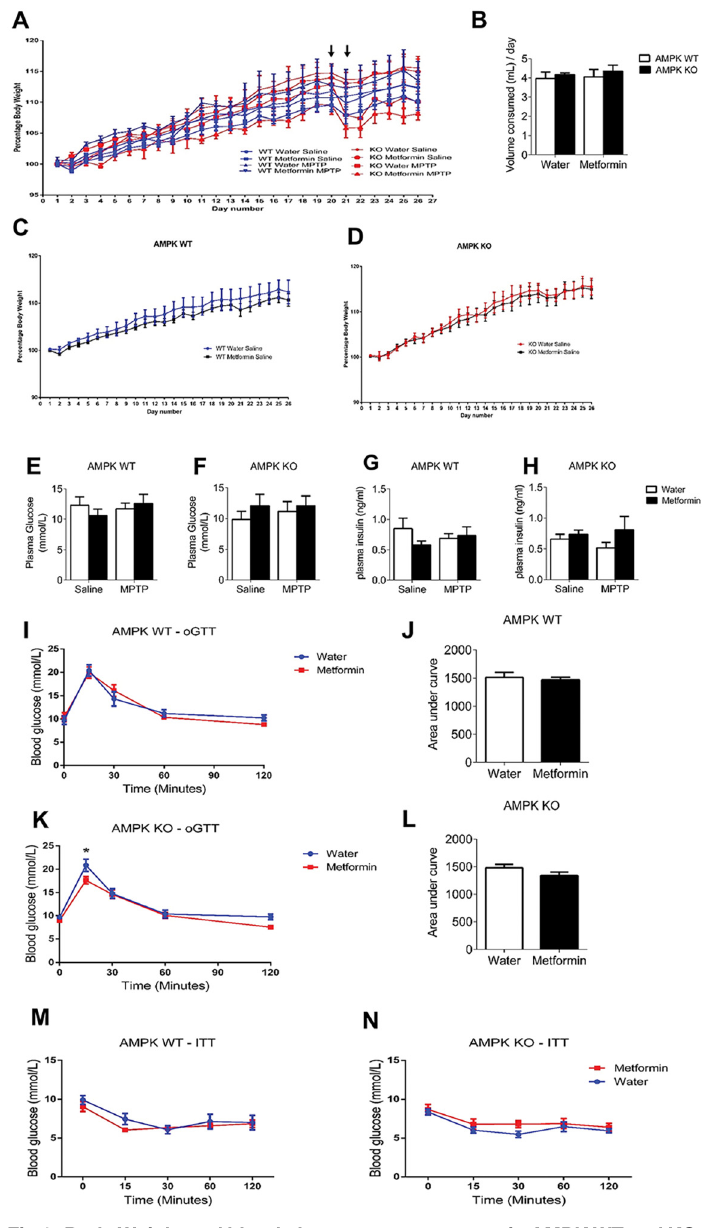
Fig 1. Body Weight and blood glucose measurements in AMPK WT and KO mice. A – D , throughout the experiment there was no difference in body weight or volume of water consumed comparing genotype or treatment. Arrows indicate MPTP injections. E – H , Plasma analysis of insulin and glucose levels in trunk blood show no differences between genotype and treatment. During an oGTT Metformin treatment does not alter glucose clearance in AMPK WT ( I & J ) or AMPK KO mice ( K & L) . Insulin sensitivity is not altered during an ITT in AMPK WT ( M ) or KO ( N ) mice treated with Metformin. * = p < 0.05. Data are represented as mean ± SEM (n = 8 – 10, two-way ANOVA, p <